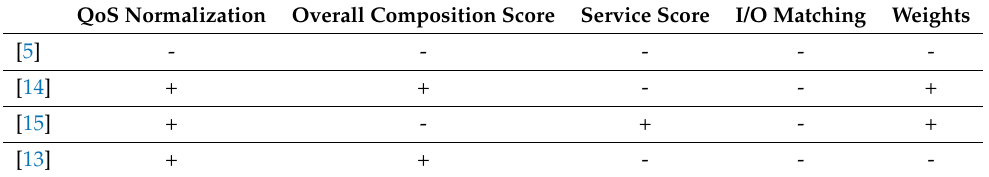
Table 2. Evaluation summary of existing works w.r.t. the service/composition quality-related